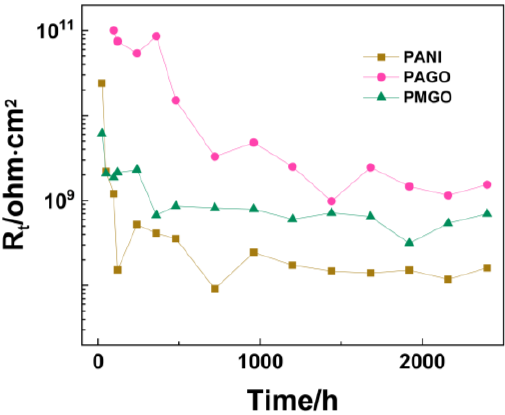
Figure 10 . Change curve of charge transfer resistance with immersion time. Figure 10. Change curve of charge transfer resistance with immersion